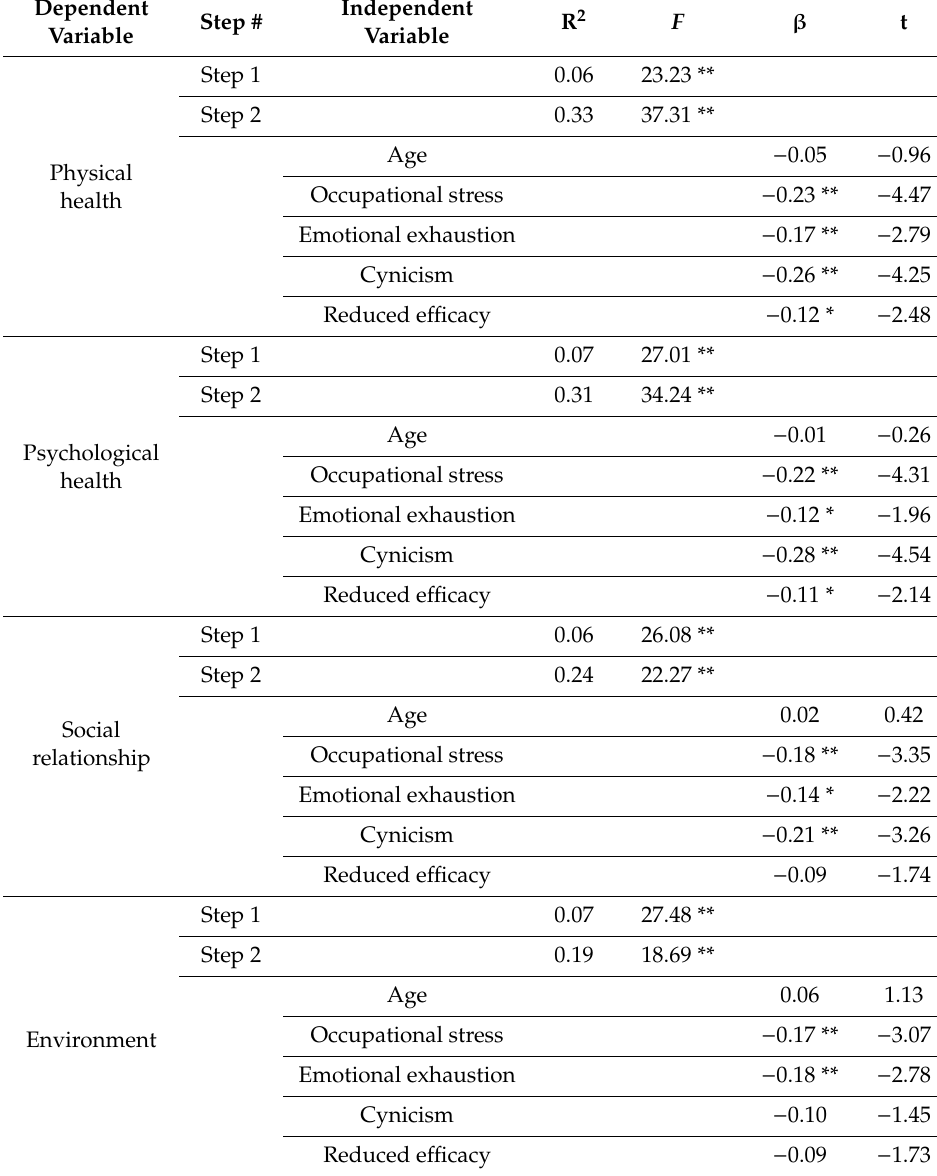
Table 2. Results of four hierarchical regressions for QoL ( N =